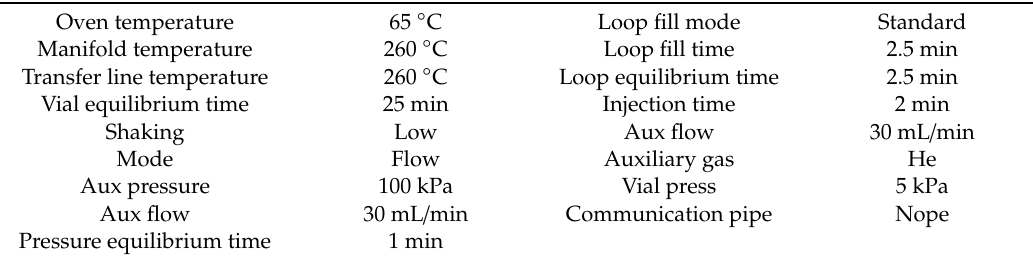
Table 2. Conditions of the Headspace autosampler.